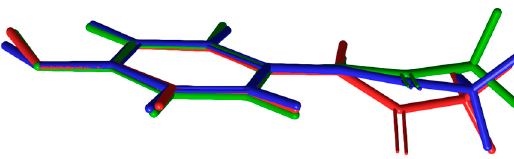
Figure 6 . Structural overlays of PCM in ( 1 ) (red) and ( 3 ) blue and green. The 44BP molecule has been omitted for clarity [29].